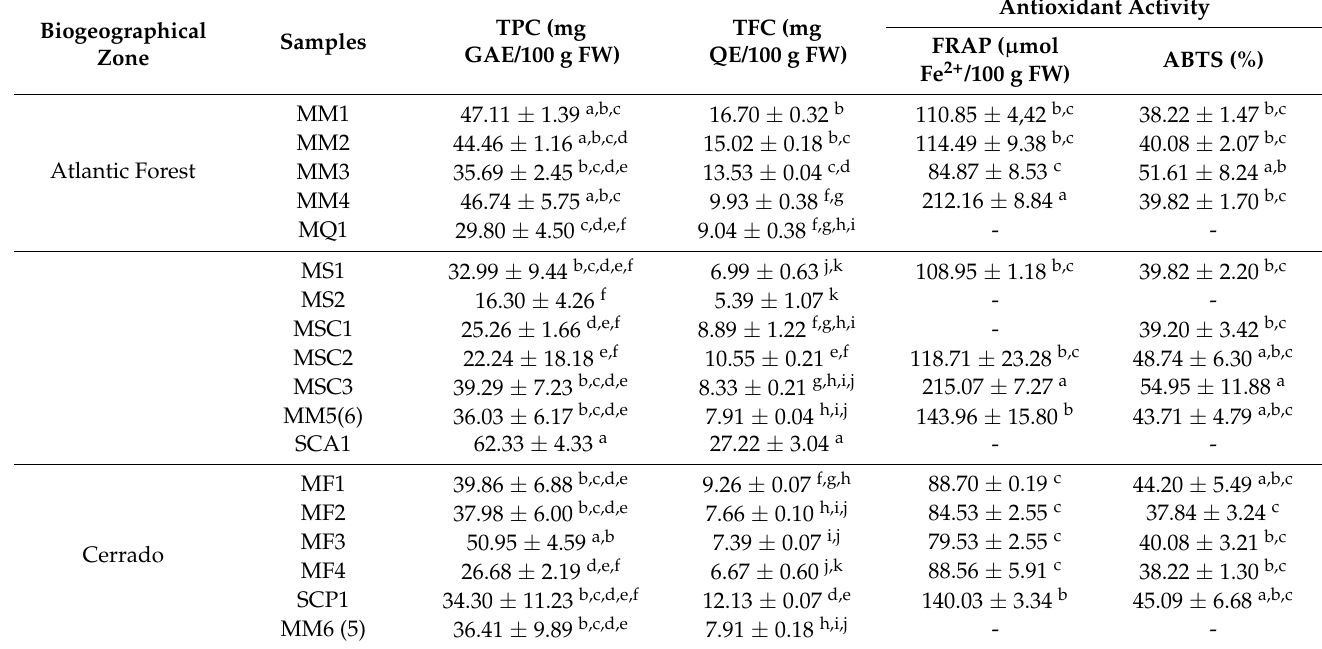
Table 3. Contents of phenolic compounds, total flavonoids, and antioxidant activity of stingless bee honey of different species from different biogeographical zones of Brazil. TPC and TFC results are expressed as mean concentration (mg/100 g FW) ± standard deviation. The FRAP result is expressed as the mean value of µ mol Fe 2+ ± standard deviation of fresh honey samples. The ABTS result is expressed as the mean percentage of free radical scavenging power ± standard deviation of fresh honey